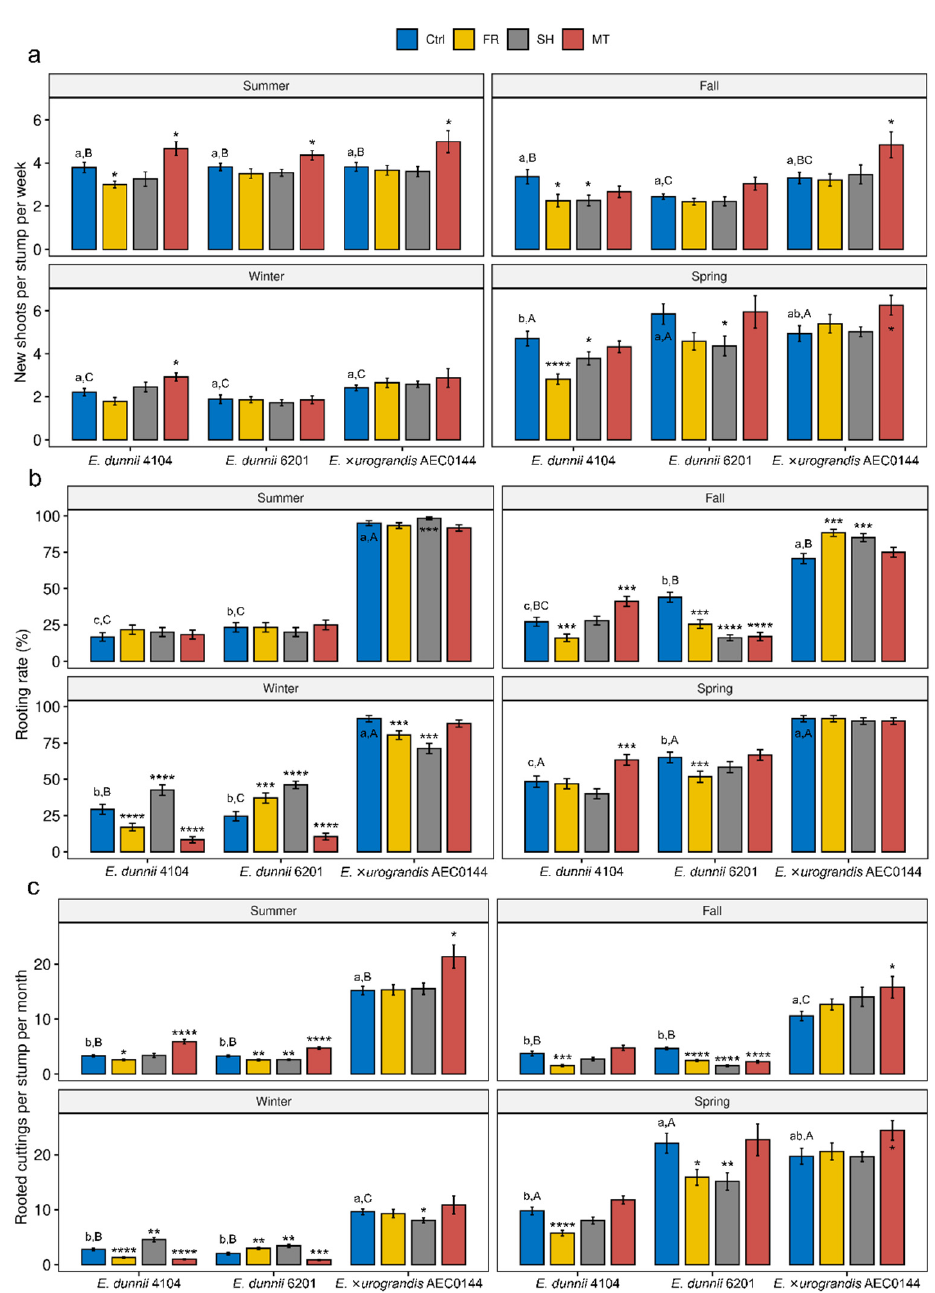
Figure 1. Impact of mini-stump environmental modulation on the propagation of Eucalyptus dunnii 4104, 6201 (hardR clones), and E. × urograndis AEC0144 (easyR) across seasons. ( a ) Number of weekly new shoots per mini-stump (21 > n > 15), ( b ) rooting rates 30 days after excision (%, 60 > n > 26), and ( c ) monthly rooted cuttings per stump (21 < n < 15) during summer, fall, winter, and spring under control (Ctrl), far-red-enriched (FR), shade nets (SH), and mini-tunnel (MT) conditions. Bars represent mean ± SEM. Asterisks indicate significant differences in the treatments in comparison to the Ctrl (* p ≤ 0.05, ** p ≤ 0.01, *** p ≤ 0.001, **** p ≤ 0.0001, Dunnett’s test). Different lowercase and uppercase letters indicate statistical significance when comparing the Ctrl results across clones in the same season and Ctrl results across seasons in the same clone, respectively (factorial ANOVA, estimated marginal means test, p ≤ 0.05).